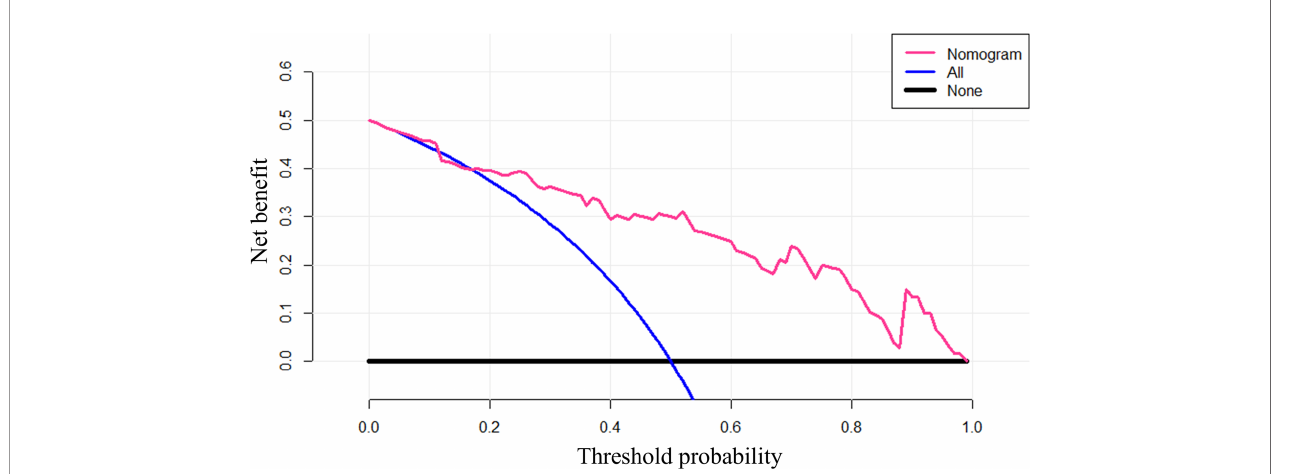
FIGURE 6 | The decision curve of nomogram. Net bene fi t was calculated as Net Benefit = True Positive n − False Positive n ( Pt true positive is the number of patients predicted by the model as positive and actually positive, and false positive is the number of patients predicted as positive and actually negative. p t is the threshold